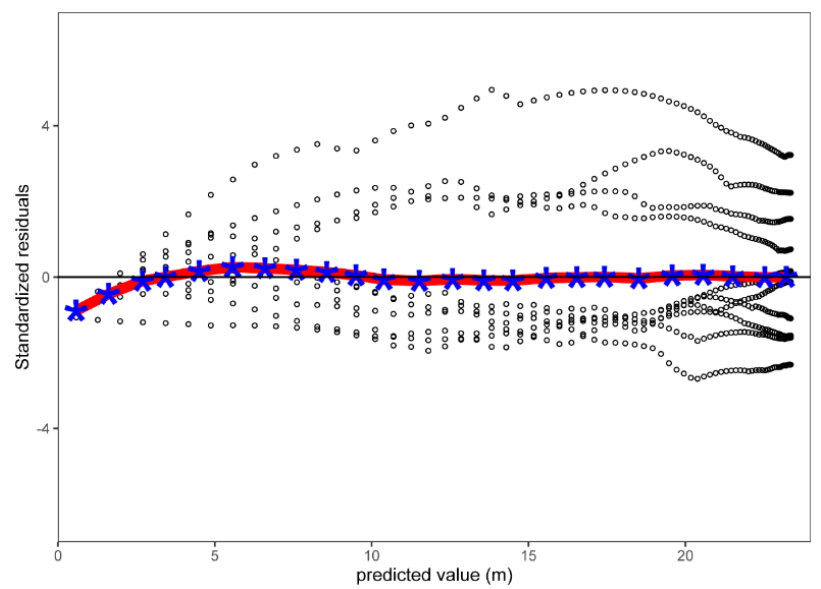
Figure 5. Prediction errors of model NLME7 for the model validation data. The mean residuals (* solid line) were calculated for one-meter site index classes.